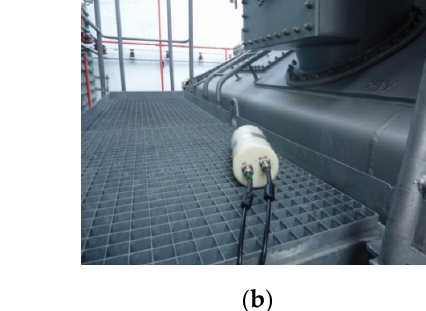
Figure 17. The external sensor for detecting outer EM impulse disturbance.